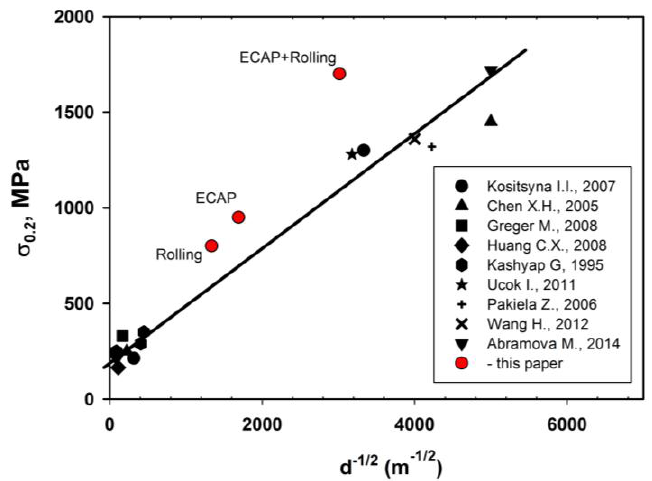
Figure 8. Hall-Petch relation for chromium-nickel austenitic steels, built on the basis of literature data [6,27–34] (back marks) and the results of the present study (red marks).